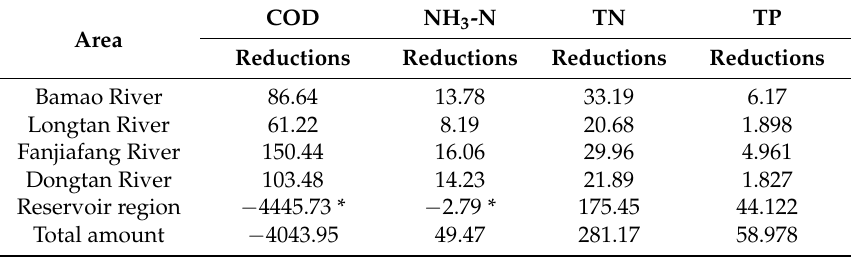
Table 13. The pollutants reduction targets of the Huangshi Reservoir in 2025 (units: tons/year). COD NH 3 -N TN Area